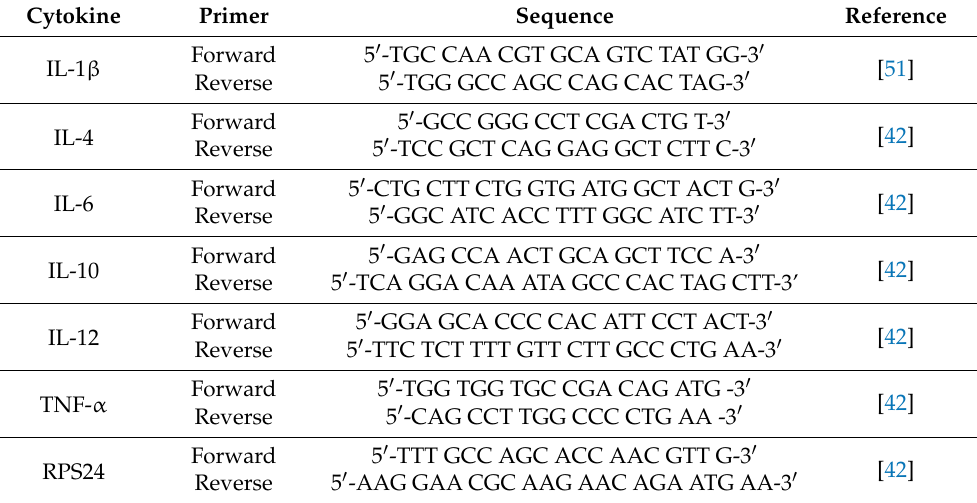
Table 1. Summary of primers used for cytokine detection via